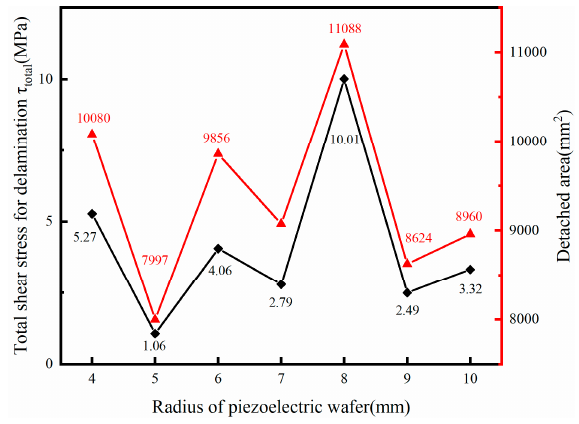
Figure 19. The trend of total shear stress τ total and detached area.